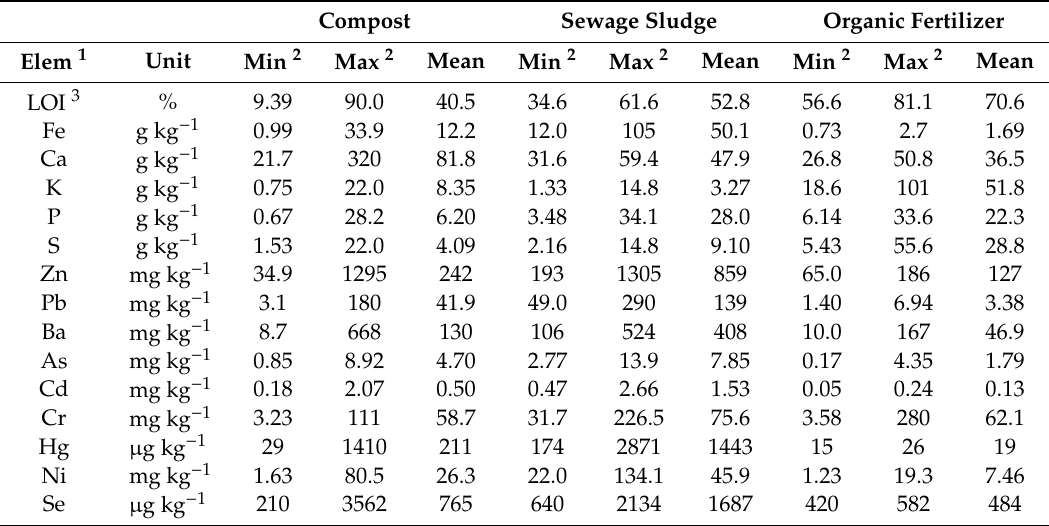
Table1. Rangesofaqua-regia-extractablecontentsofselectedelementsofthedi ff erentamendmenttypes. Compost Sewage Sludge Organic Fertilizer